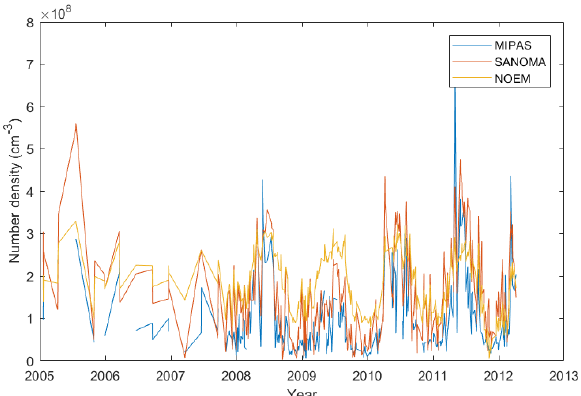
Figure 22. Time series of NO number density measured with MI- PAS and simulated with SANOMA as well as NOEM, 102km alti- tude, − 70 ◦ (cid:51)